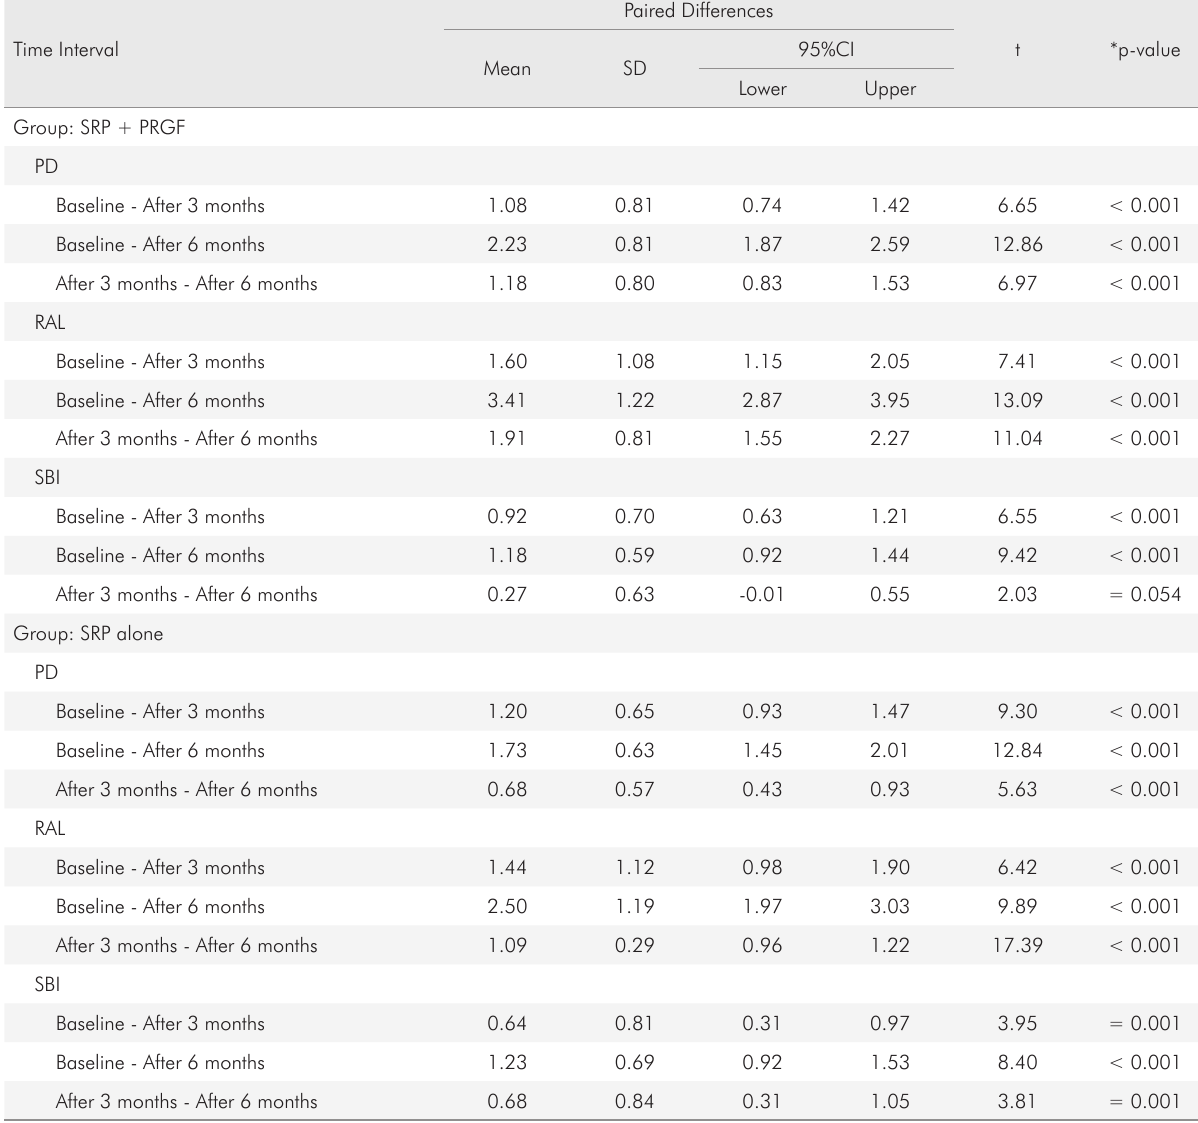
Table 2. Intra-group comparison of clinical outcomes between SRP +PRGF versus SRP alone at baseline, 3 and 6 months.